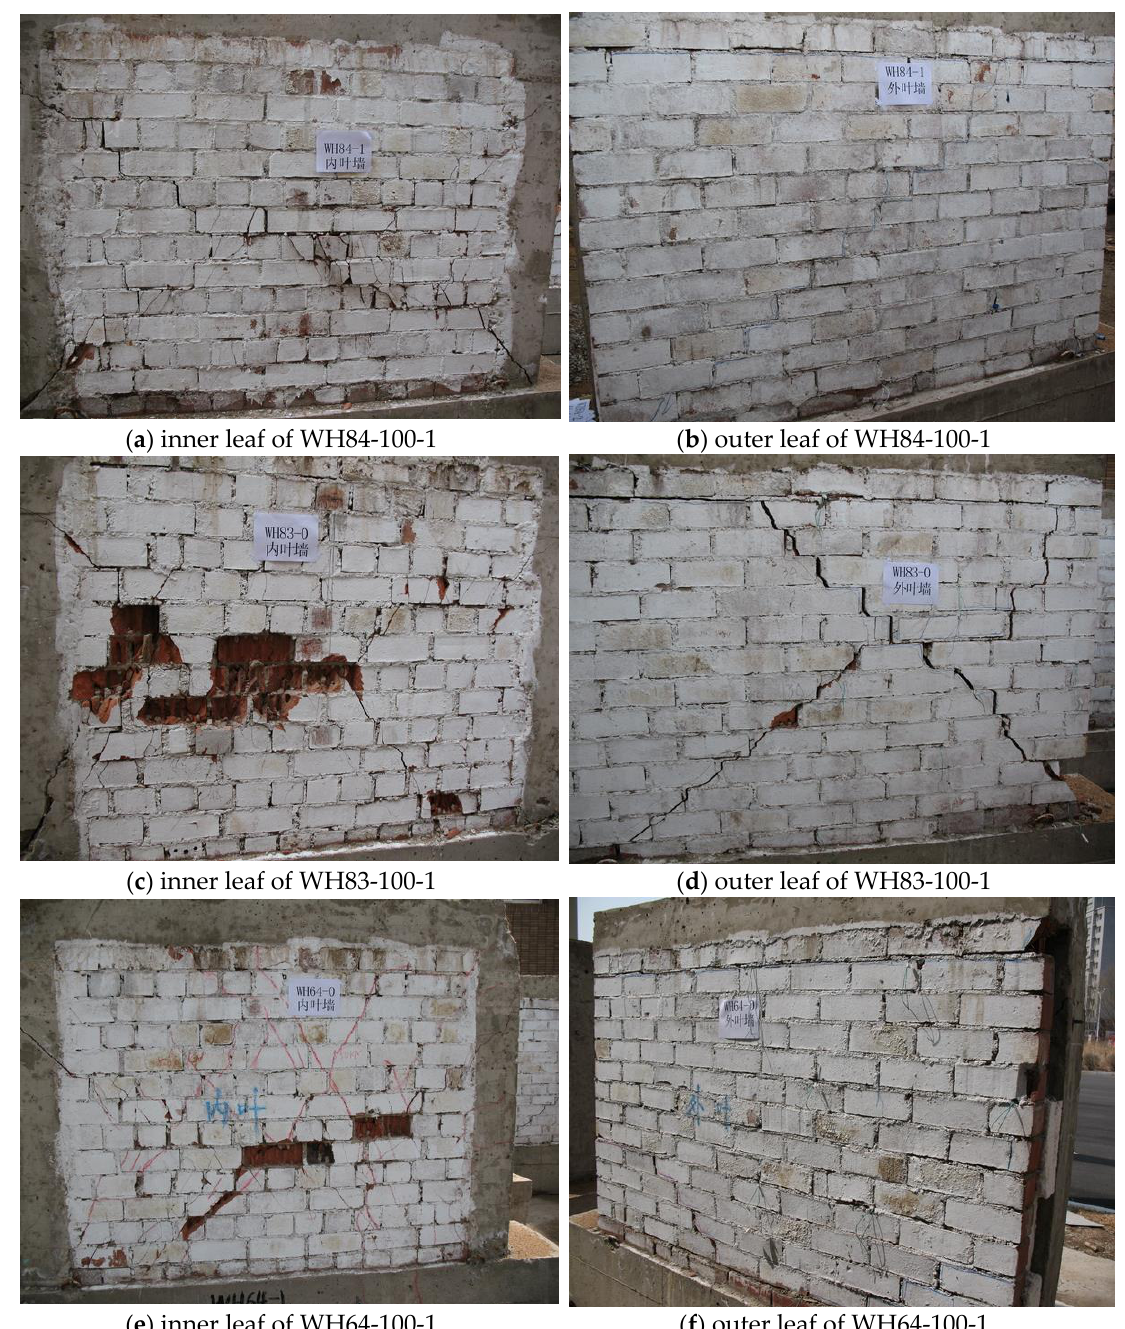
Figure 7. Damage state of the walls upon loading.